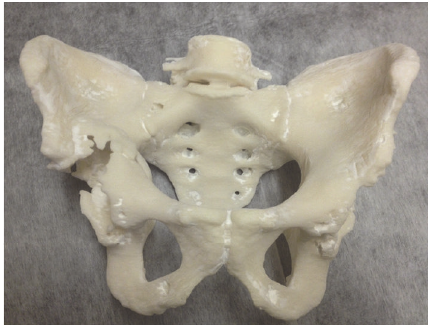
Figure 10: A life-size 3D printed model of the first